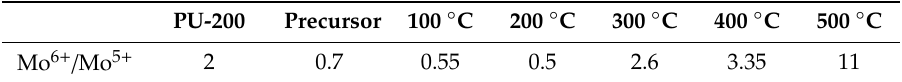
Figure 3. XPS spectra for the TiF 4 -PU composites obtained at different temperatures. ( a ) Mo 3d ; ( b ) O 1s ; ( c ) Zr 3d ; ( d ) P 2p . Table 2. The molar ratio of Mo 6+ /Mo 5+ in the PU (PMA + UiO-66) and TiF 4 -PU catalysts according to the XPS fitting results.